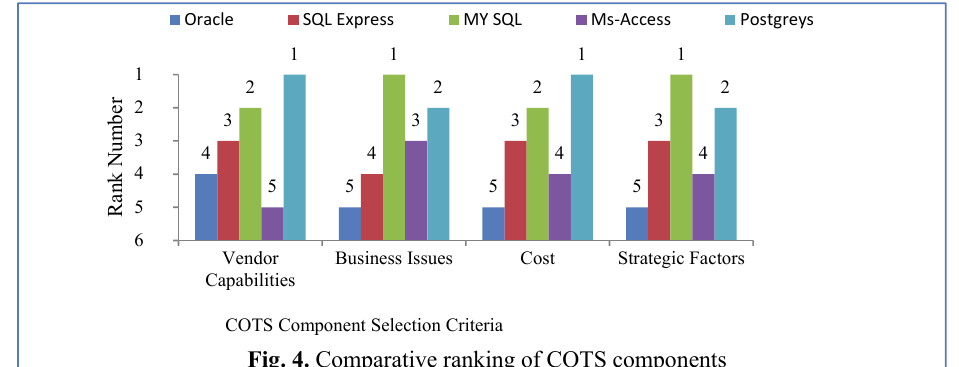
Fig. 4. Comparative ranking of COTS